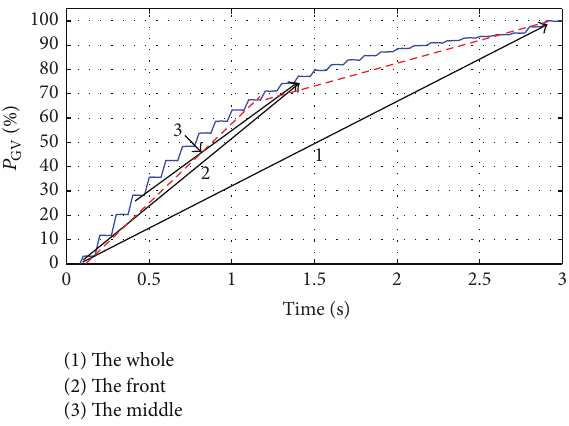
Figure 3: Opening time constant calculation